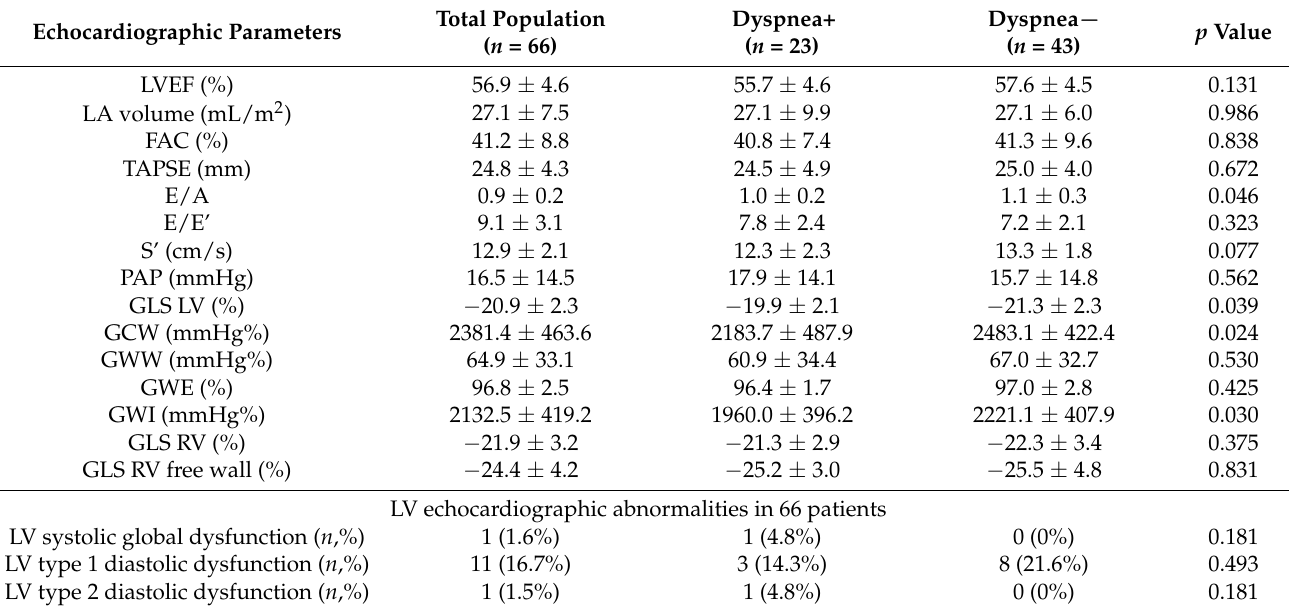
Table 1. Echocardiographic parameters.